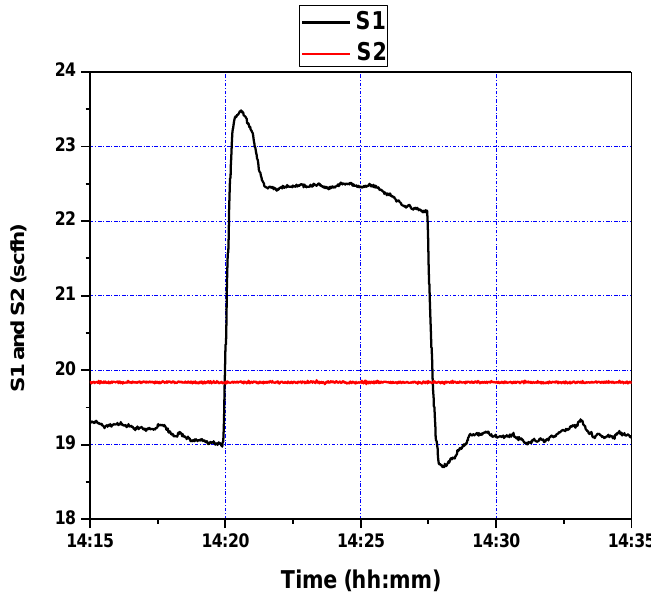
Figure 10. Fluidizing air flow control (S1 and S2) during step setpoint changes.